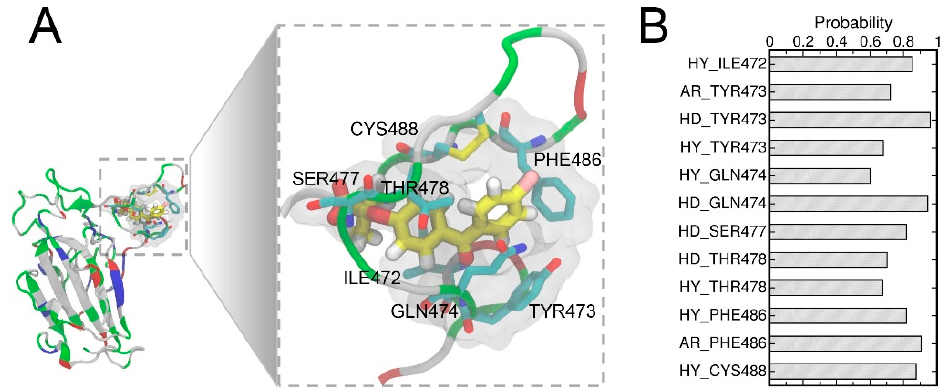
Figure 5. The binding pocket in a close view ( A ) showing the important labeled residues. The FA molecule is shown in the stick representation and the hydrogen, carbon, oxygen, and chloride atoms of FA are shown in white, yellow, red, and pink, respectively. The important protein–ligand interactions were analyzed using the MD-IFP tool [60], whereas HY and AR denote hydrophobic interactions and aromatic contacts with the protein residues, respectively, while HD denotes residues acting as hydrogen bond donors ( B ).